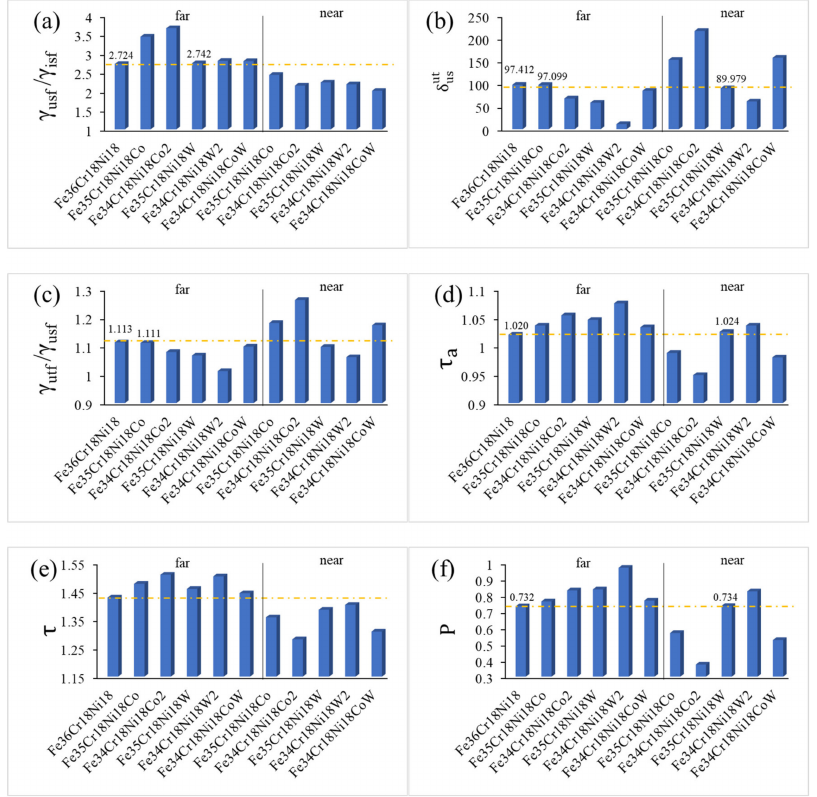
Figure 11. Ranking of di ff erent systems in the present work based on; ( a ) ratio of γ usf / γ isf , ( b ) δ ut us , ( c ) ratio of γ utf / γ usf , ( d ) twinnability τ a for crack tip twinning, ( e ) twinnability τ for grain boundary twinning and ( f ) twinnability P for inherent